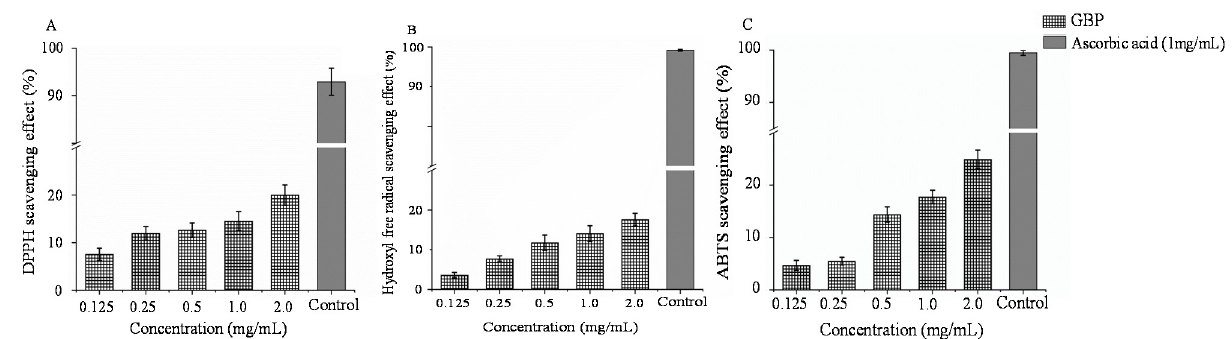
Figure 5. ( A ) DPPH scavenging effect, ( B ) HO scavenging effect and ( C ) ABTS scavenging effect of G. blodgettii polysaccharide (mean ± standard deviation, n = 3).